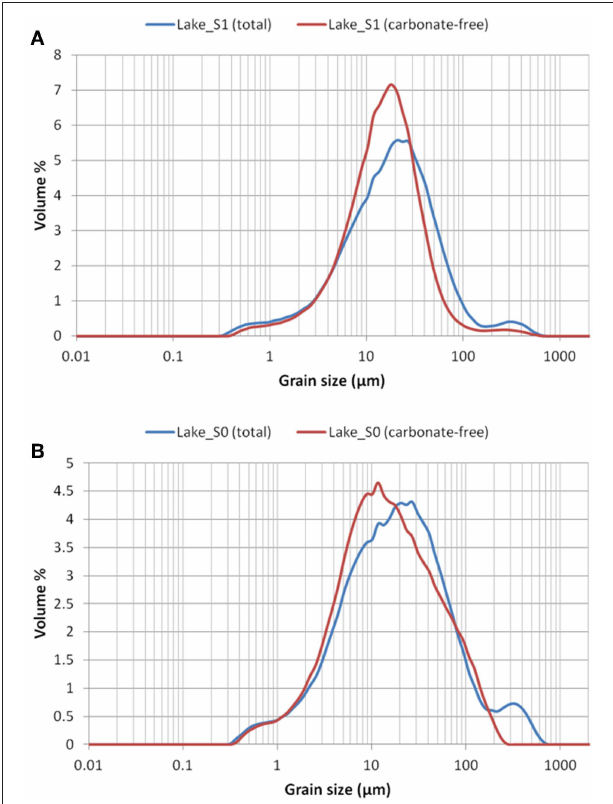
FIGURE 6 | Results of sedimentological analysis of samples collected by the Lake Lander at 265m depth at Site Amazon Cave Dive (S1) in April 2015 (A) and at 272m depth at Kraken Dive (S0) in 2013 (B) . Variation in % volume of grains of different size is shown both for the total sample and for the carbonate-free